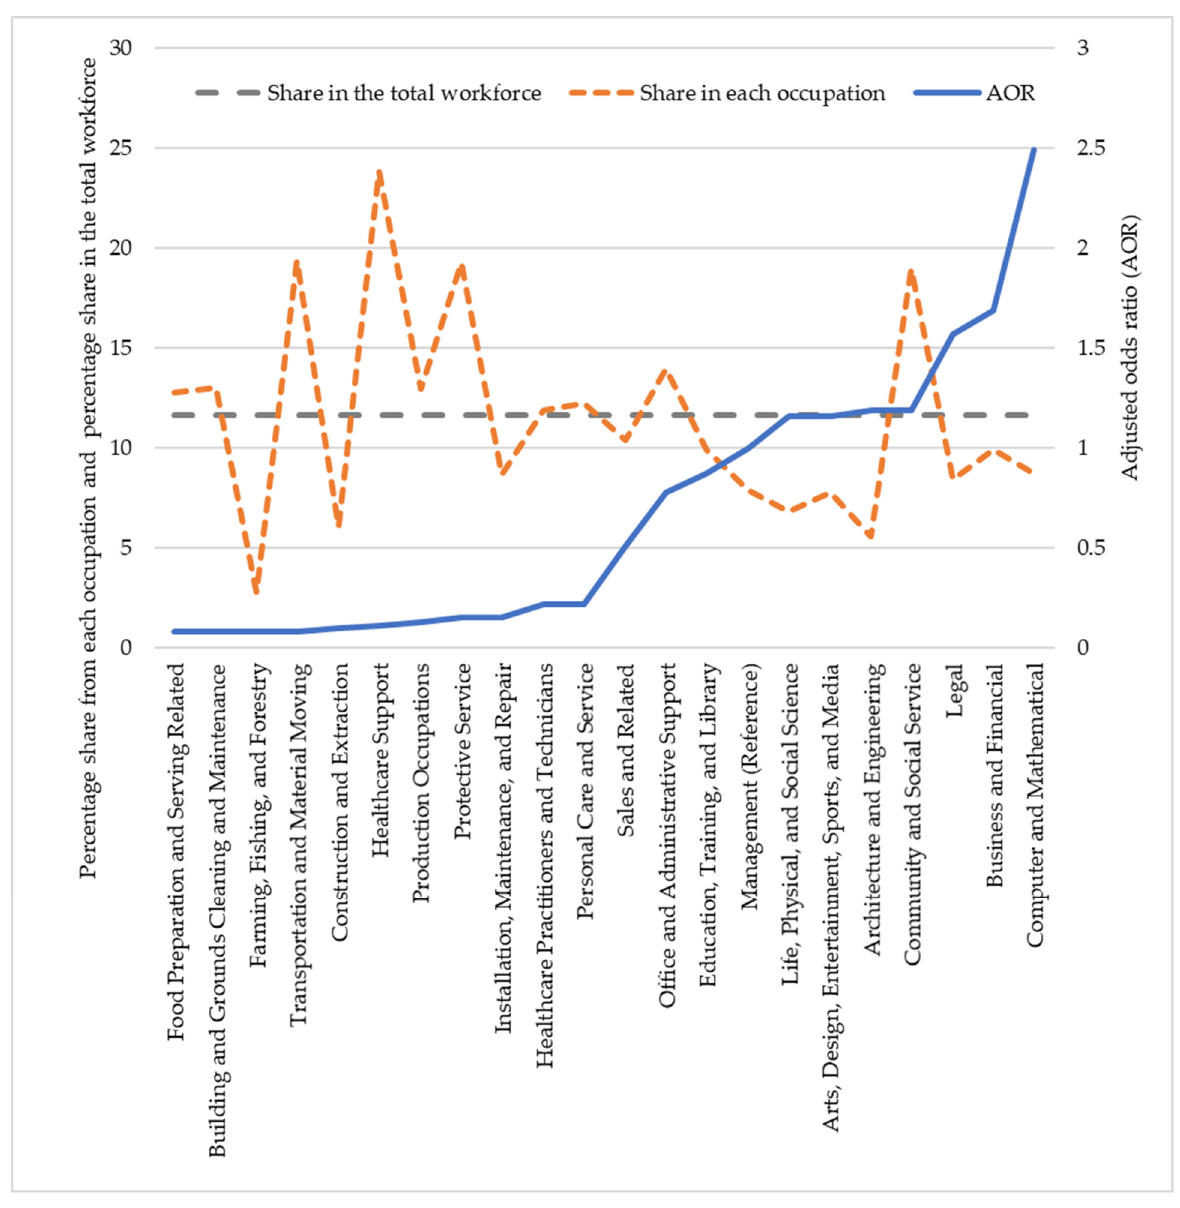
Figure 2. Adjusted odds ratio (AOR) of teleworking in each occupation and share of Black workers in each occupation and in the total workforce.